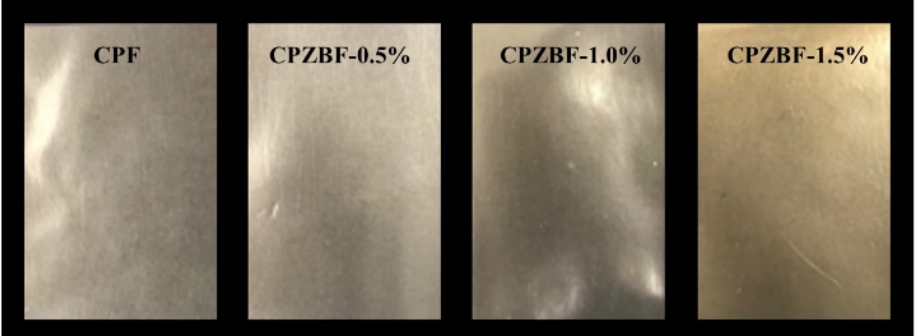
Figure 2. Photographs of the crosslinked pectin film (CPF) and the crosslinked pectin/ZnO bionano- composite films (CPZBF) containing 0.5~1.5% ZnO-NPs.